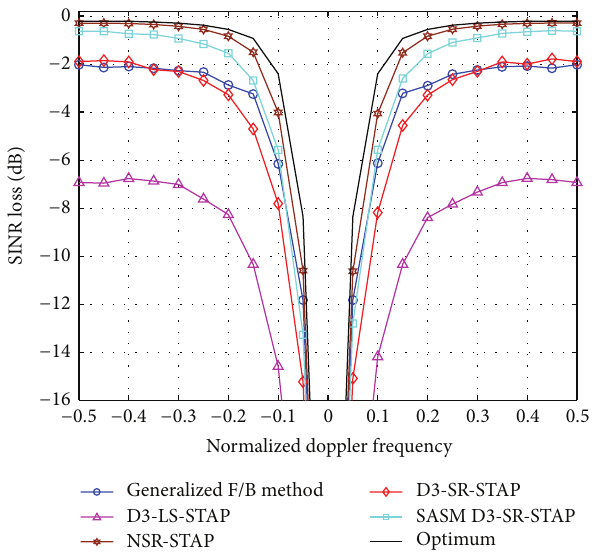
Figure 6: SINR loss against the target Doppler frequency consider- ing ICM.